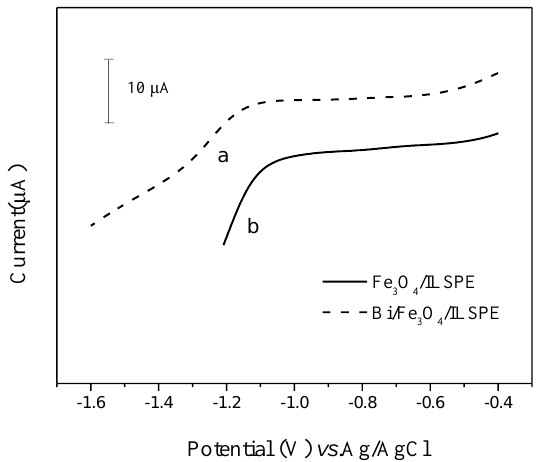
Figure 4. Linear sweep voltammograms in 0.2 mol/L phosphate buffer solution ( a ) Bi/Fe 3 O 4 /ILSPE, ( b ) Fe 3 O 4 /ILSPE.